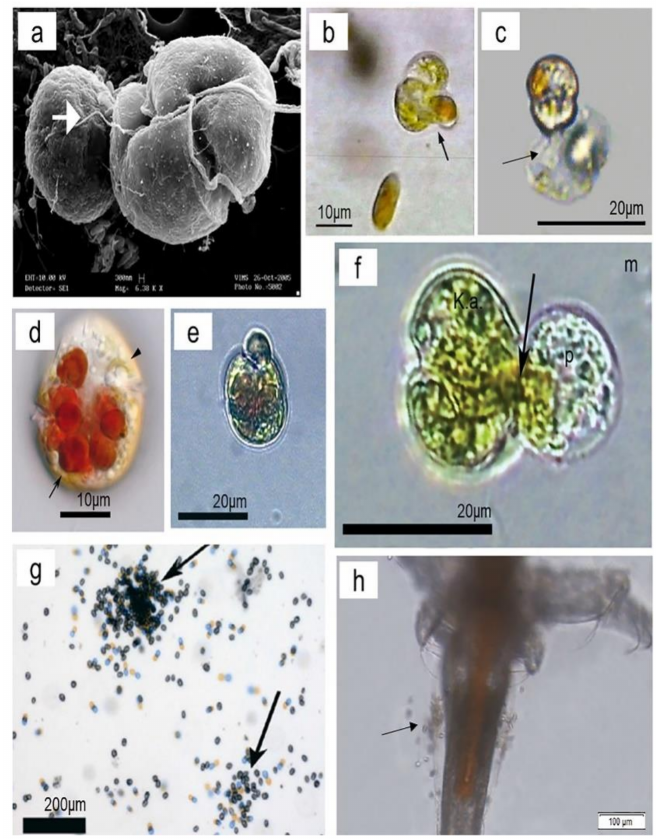
Figure 1. The phagotrophic behavior of Karlodinium . ( a ) SEM of K. veneficum feeding on Rhodomonas sp. The thin filament is marked with an arrow (the photo was modified from Place et al. [72]). ( b ) A cell of K. veneficum was engulfing whole cells of Storeatula major . The “lip-like” protrusion was observed to gradually move laterally along the prey surface, which causes further engulfment of the prey cell (the photo was modified from Li et al. [20]). ( c ) Karlodinium veneficum ingest a dead cell of con-species by myzocytosis using peduncles. Karlodinium veneficum was searching for cytoplasm by opening the peduncle (arrow) widely in the dead cell (the photo was modified from Yang et al. [16]). ( d ) Subsurface ventral view of K. australe after feeding overnight on Rhodomonas salina . Note light yellow-green chloroplasts (arrowhead) and red food vacuoles (arrow, the photo was modified from de Salas et al. [28]). ( e ) Karlodinium armiger was ingesting the cryptophyte Rhodomonas salina by direct engulfment (the photo was modified from Berge et al. [59]). ( f ) Karlodinium armiger was ingesting the raphidophyte Fibrocapsa japonica (p) by myzocytosis (the photo was modified from Berge et al. [59]). The peduncle was shown by the arrow. ( g ) Aggregations (arrows) of K. armiger cells in cultures fed the thecate dinoflagellate Prorocentrum minimum (the photo was modified from Berge et al. [59]). ( h ) Aggregations (arrows) of K. veneficum cells fed an injured brine shrimp Artemia salina (the photo was modified from Yang et al.